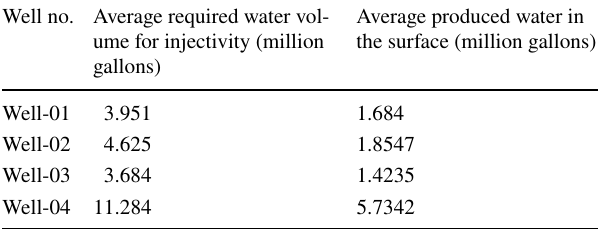
Table 4 Required and produced water in water